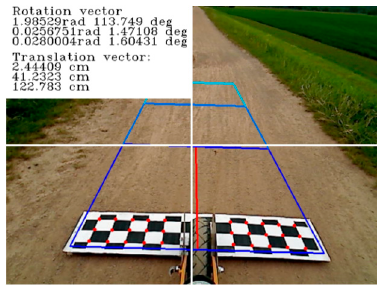
Figure 7. Computed camera parameters from the pattern in the image.